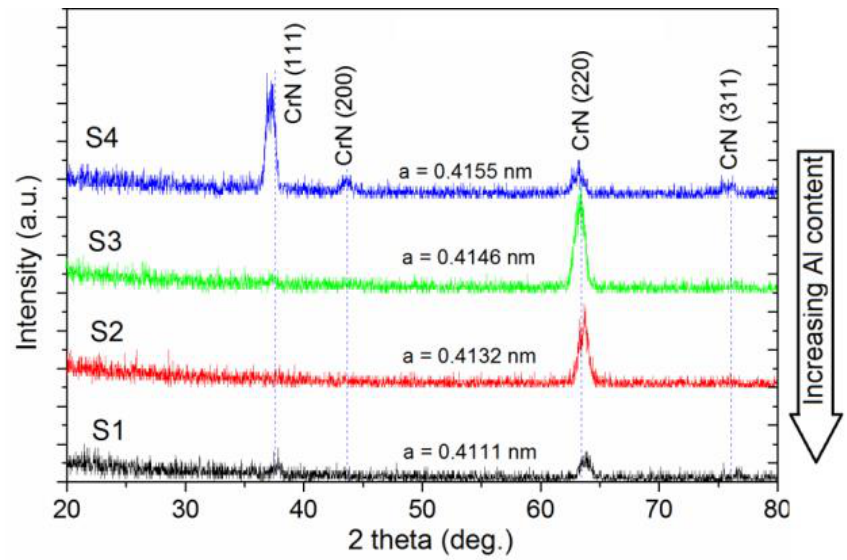
Figure 3. XRD patterns of (Cr 1−x Al x )N coatings.